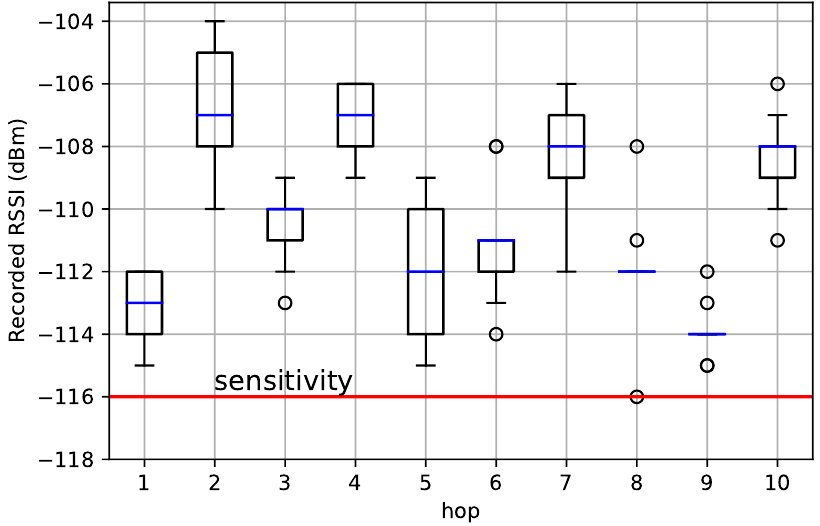
Figure 13. The RSSI at the receiving mote of each hop, when using the OpenMote B. The red bar shows the sensitivity of that radio in the configuration we used: we needed the RSSI of each hop to be above